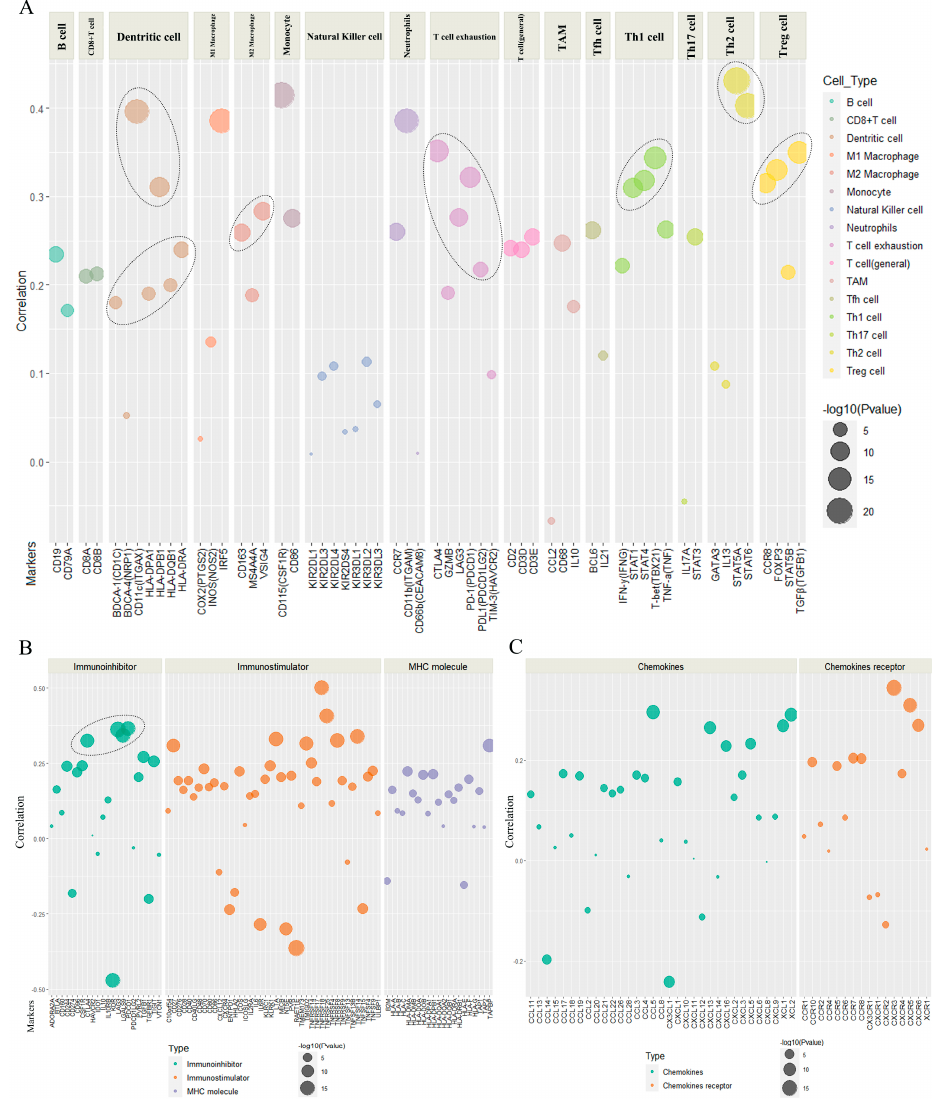
Figure 5. The relationship of POLD1 expression with marker gene sets of immune cells, immunomodulators and chemokines. ( A – C ) The bubble plot shows the association of the POLD1 gene with the marker sets of 16 diverse immune cells or their status ( A ); markers of immunomodulators ( B ); as well as markers of chemokines/chemokine receptors ( C ).